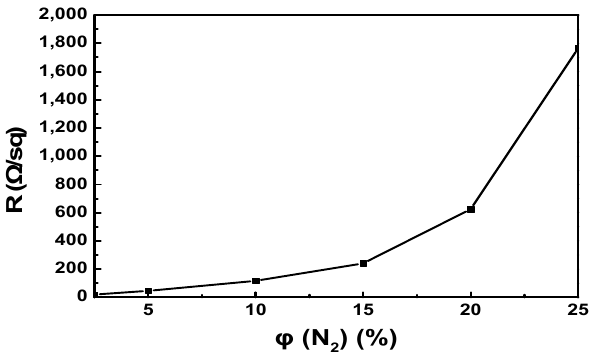
Figure 6. Relationship between nitrogen flow ratio and sheet resistance.